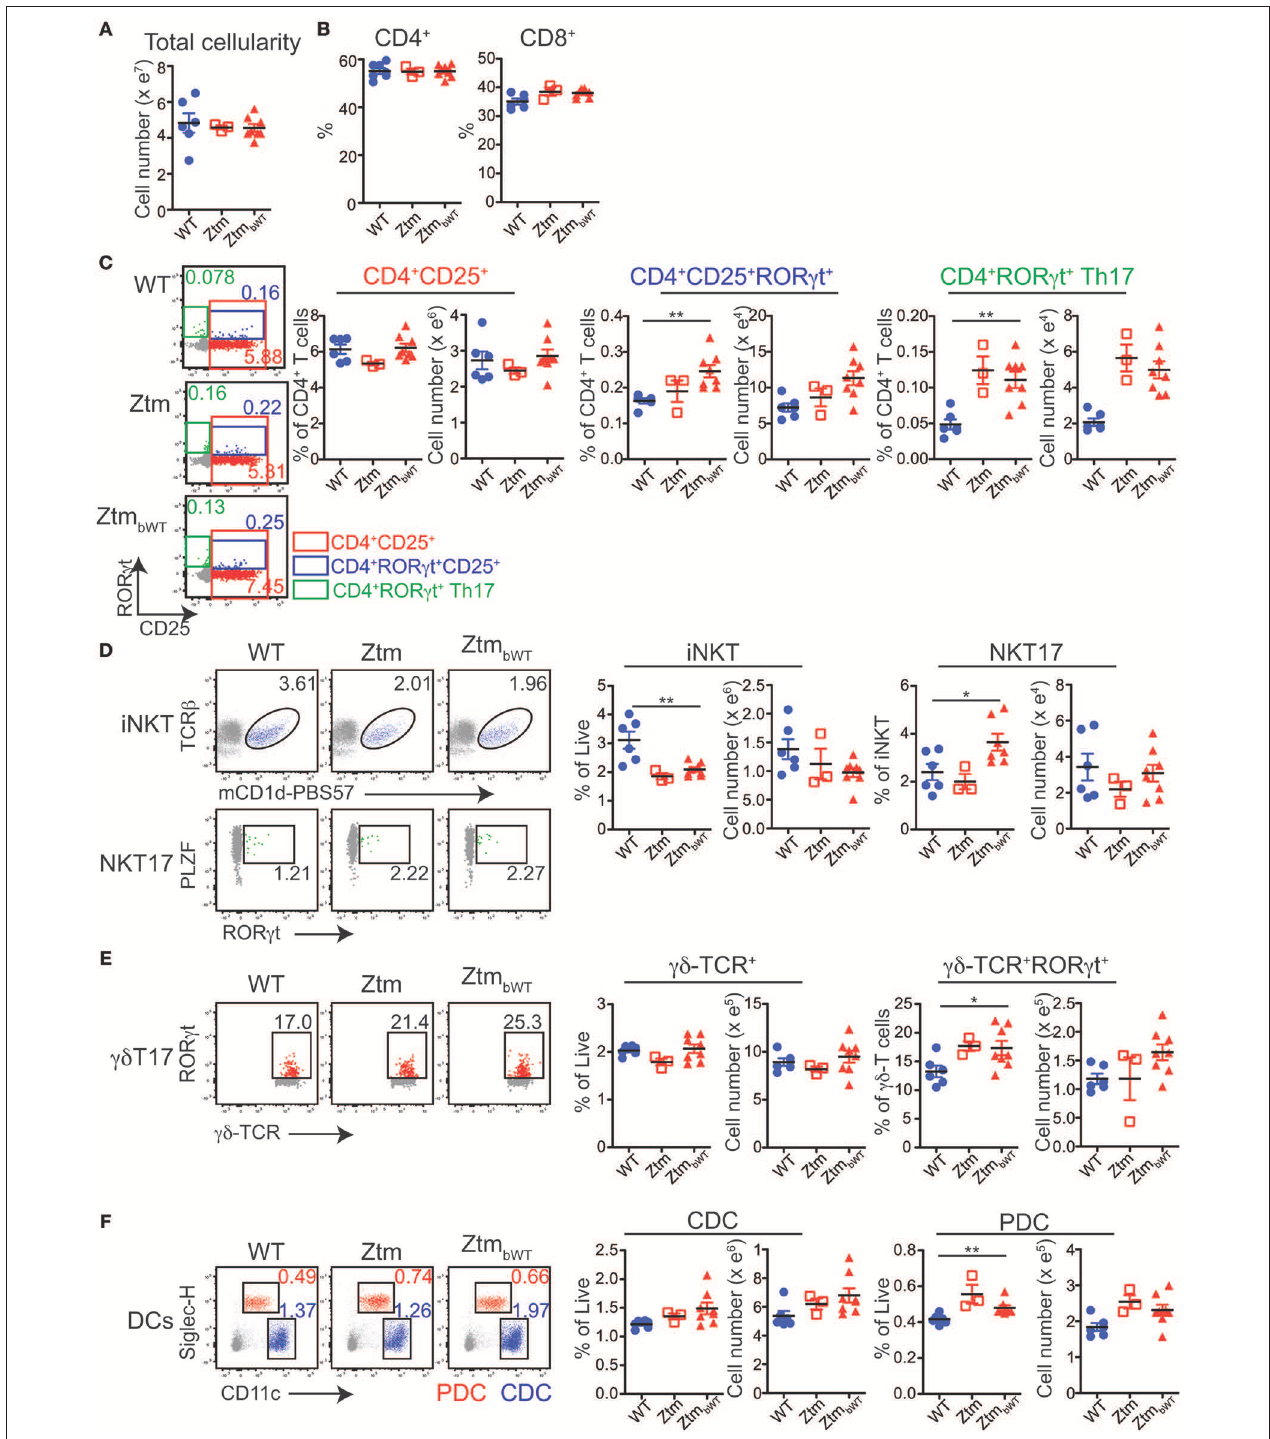
FIGURE 6 | Distribution of immune cell subsets in spleen of WT and Ztm/ZtmbWT mice: single cell preparations from the spleen of 28–35 days old WT ( n = 6), Ztm ( n = 3), and ZtmbWT ( n = 8) mice analyzed by flow cytometry. (A) Total splenic cellularity. (B) Vertical scatter plots show frequency of IL7R + TCR β + CD4 + and CD8 + T cells. (C) (Left) Representative flow cytometry dot plots show expression of CD25 (x-axis) and ROR γ t (y-axis) on CD4 + T cells. (Right) Vertical scatter plots show frequency and cell numbers of CD4 + CD25 + cells, CD4 + CD25 + ROR γ t + cells, and CD4 + ROR γ t + Th17 cells. (D) (Left) Representative flow cytometry dot plots show expression of (Top row) mCD1d-PBS57 tetramer (x-axis) and TCR β (y-axis) on IL7R + cells and (Bottom row) ROR γ t (x-axis) and PLZF (y-axis) on mCD1d-PBS57 tetramer + TCR β + iNKT cells. (Right) Vertical scatter plots show frequency and cell numbers of iNKT cells and ROR γ t + NKT17